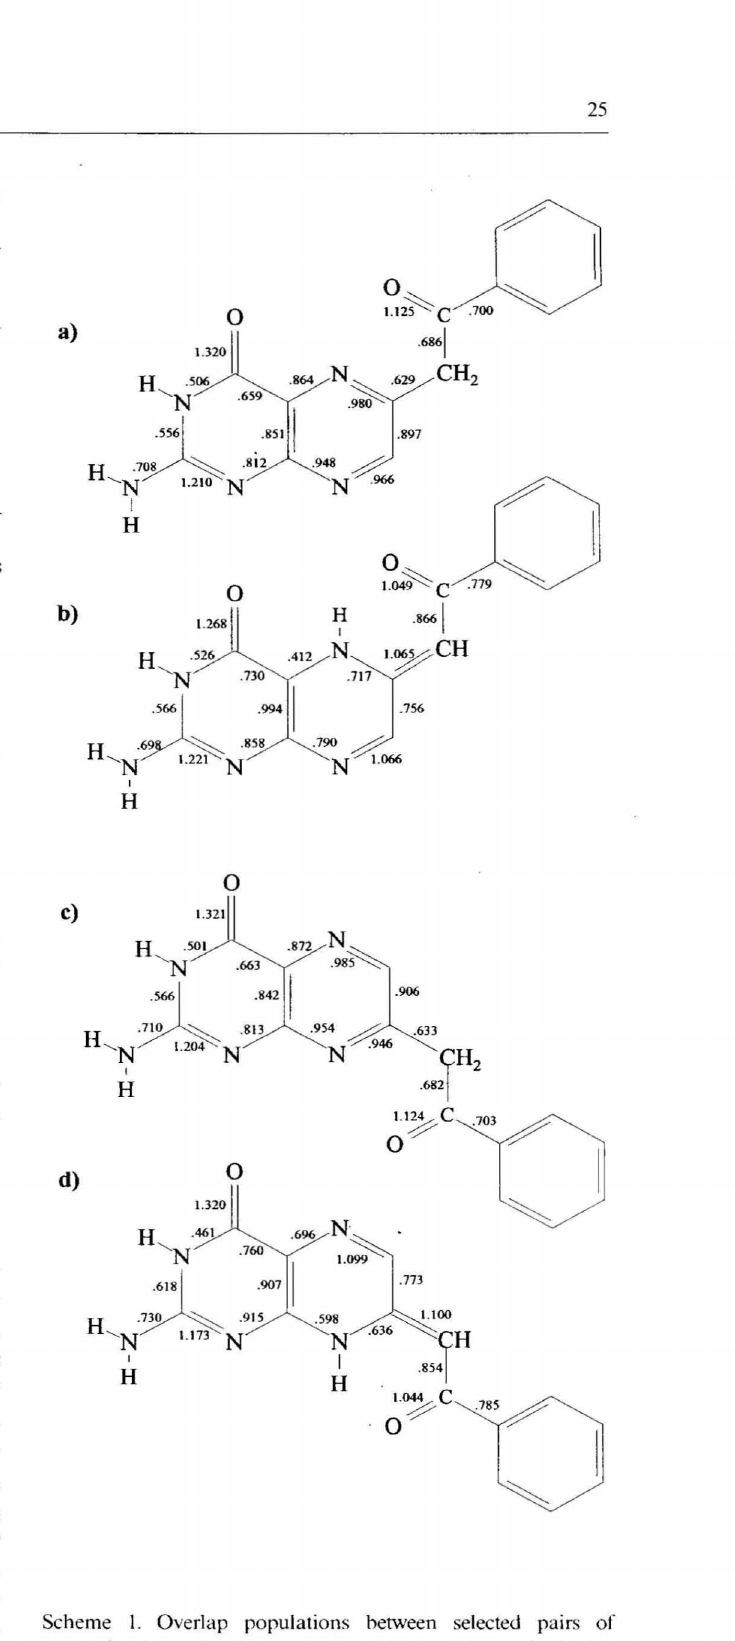
Scheme I. Overlap populations hetween selected pairs